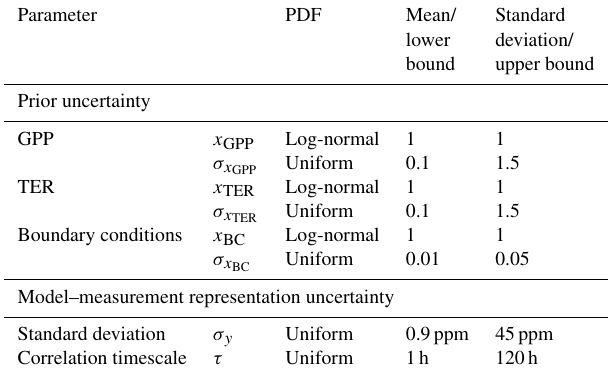
Table 3. Probability density functions (PDFs) for parameter and hyper-parameter scaling factors. Mean and standard deviation in the fourth and fifth columns relate to log-normal PDFs; lower bound and upper bound relate to uniform